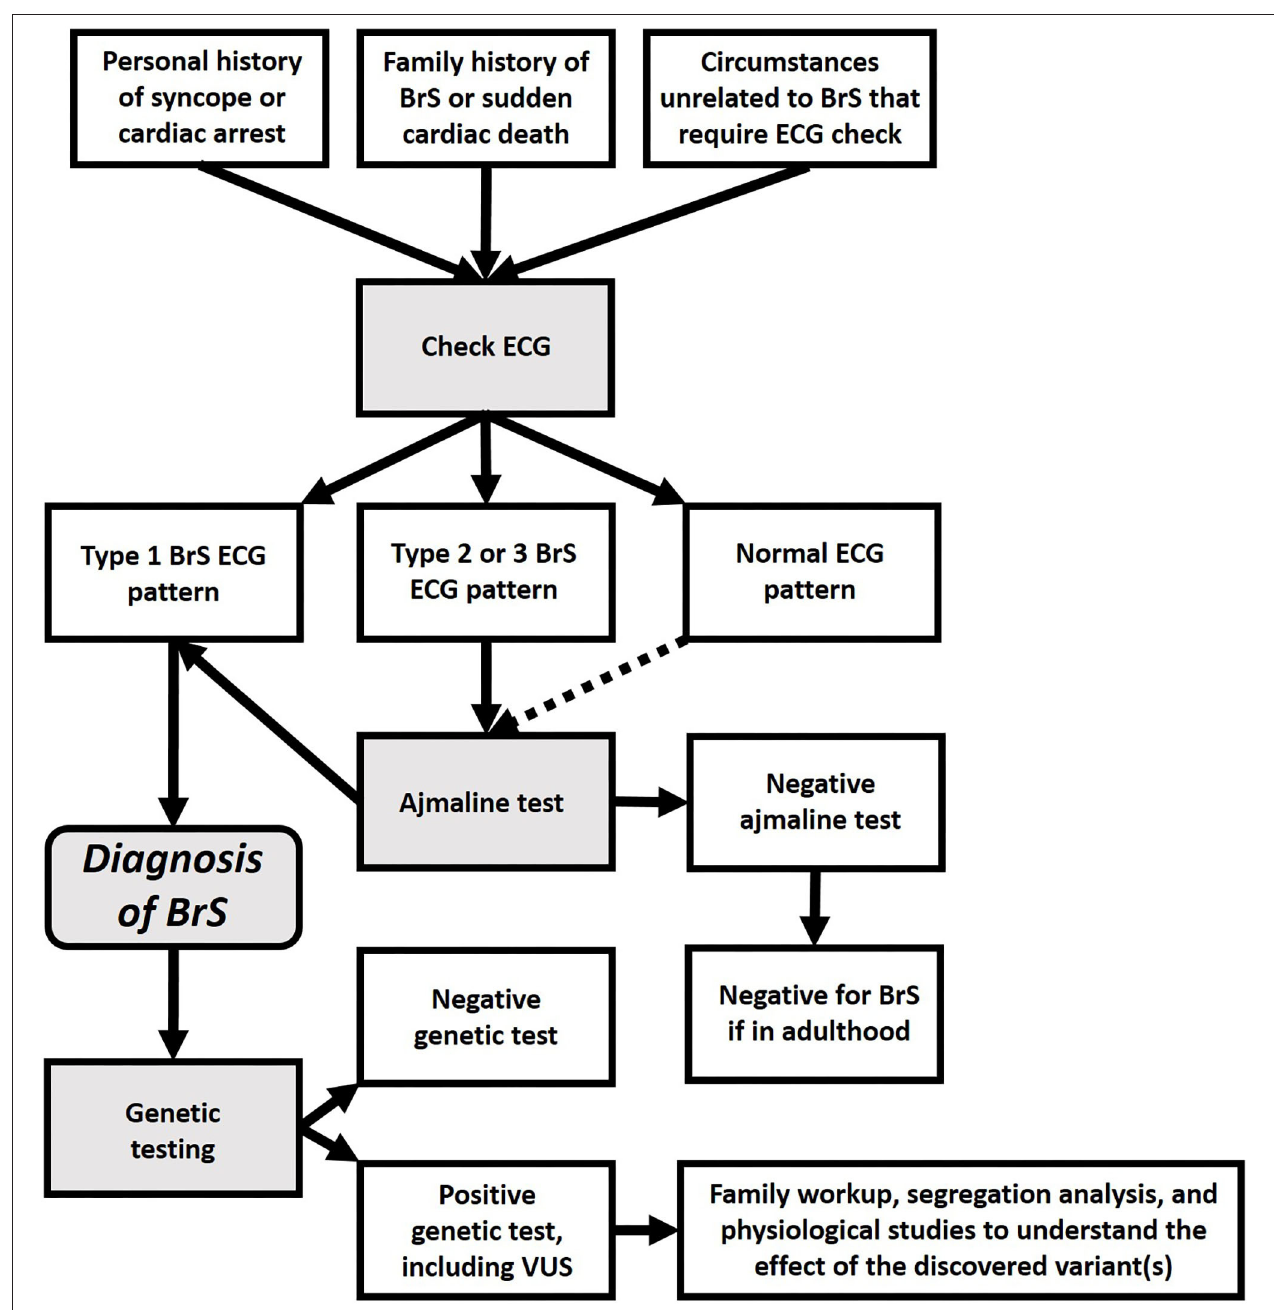
FIGURE 2 | Flowchart for the diagnosis of BrS and genetic